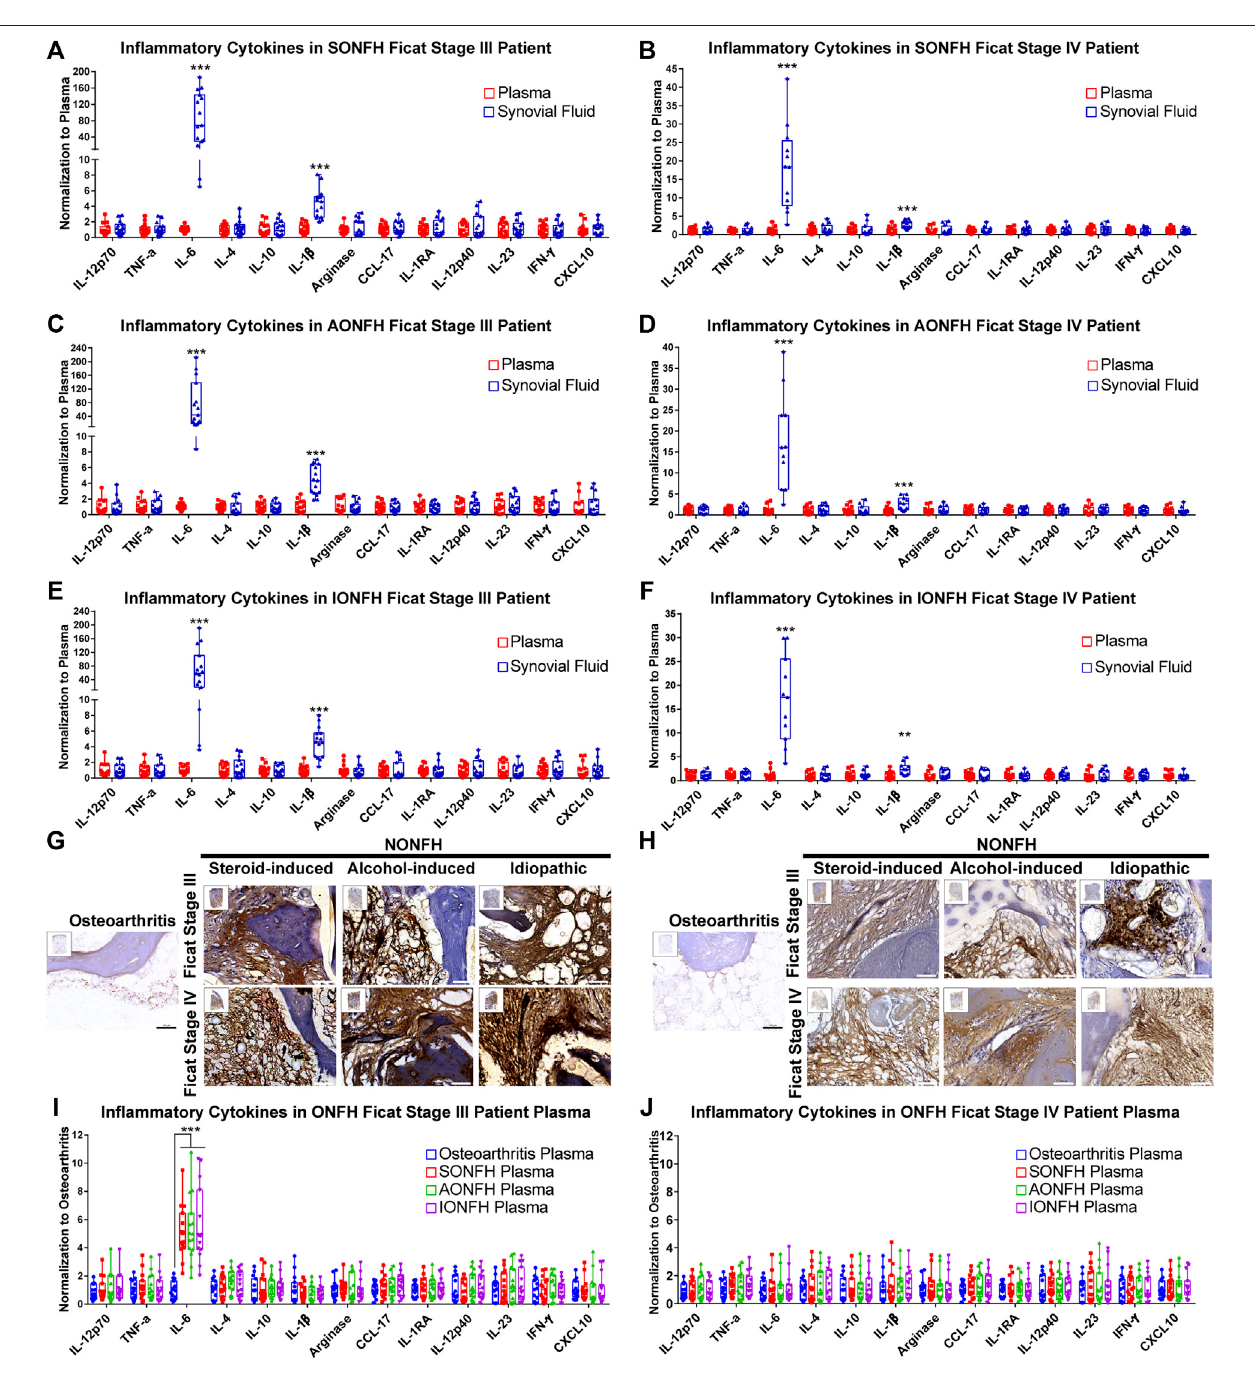
FIGURE 4 | IL-6 and IL-1 β maintained the local chronic in fl ammatory microenvironment in human NONFH (A-F) Comparison of the levels of cytokines in synovial fl uidandplasmainpatientswithdifferenttypesandstagesofNONFH (G,H) Representativeimagesof (G) interleukin-6(IL-6)and (H) interleukin-1 β (IL-1 β )infemoralhead specimens from patients withdifferenttypes and stages ofNONFHor with osteoarthritis,based on immunohistochemistry (IHC). Scale bar,100 μ m (I,J) Comparison of cytokine levels in plasma of patients with different types and stages of NONFH or with osteoarthritis. * p < 0.05; ** p < 0.01; *** p < 0.001.